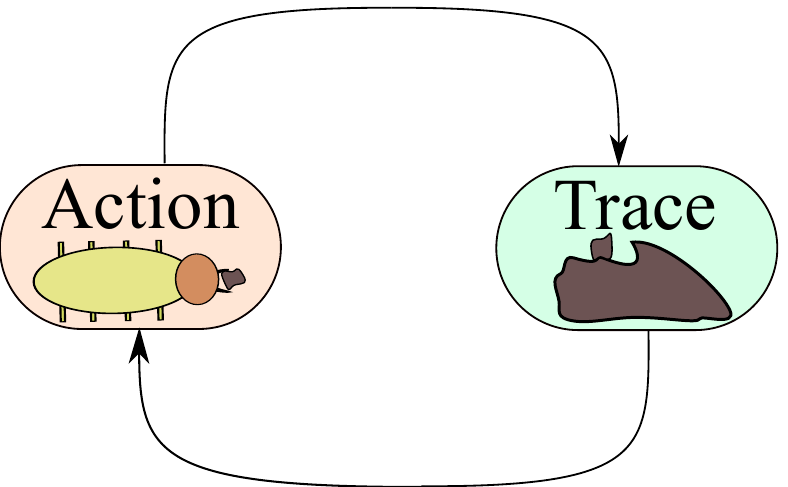
Figure 1. A simple graphic of stigmergy as a closed